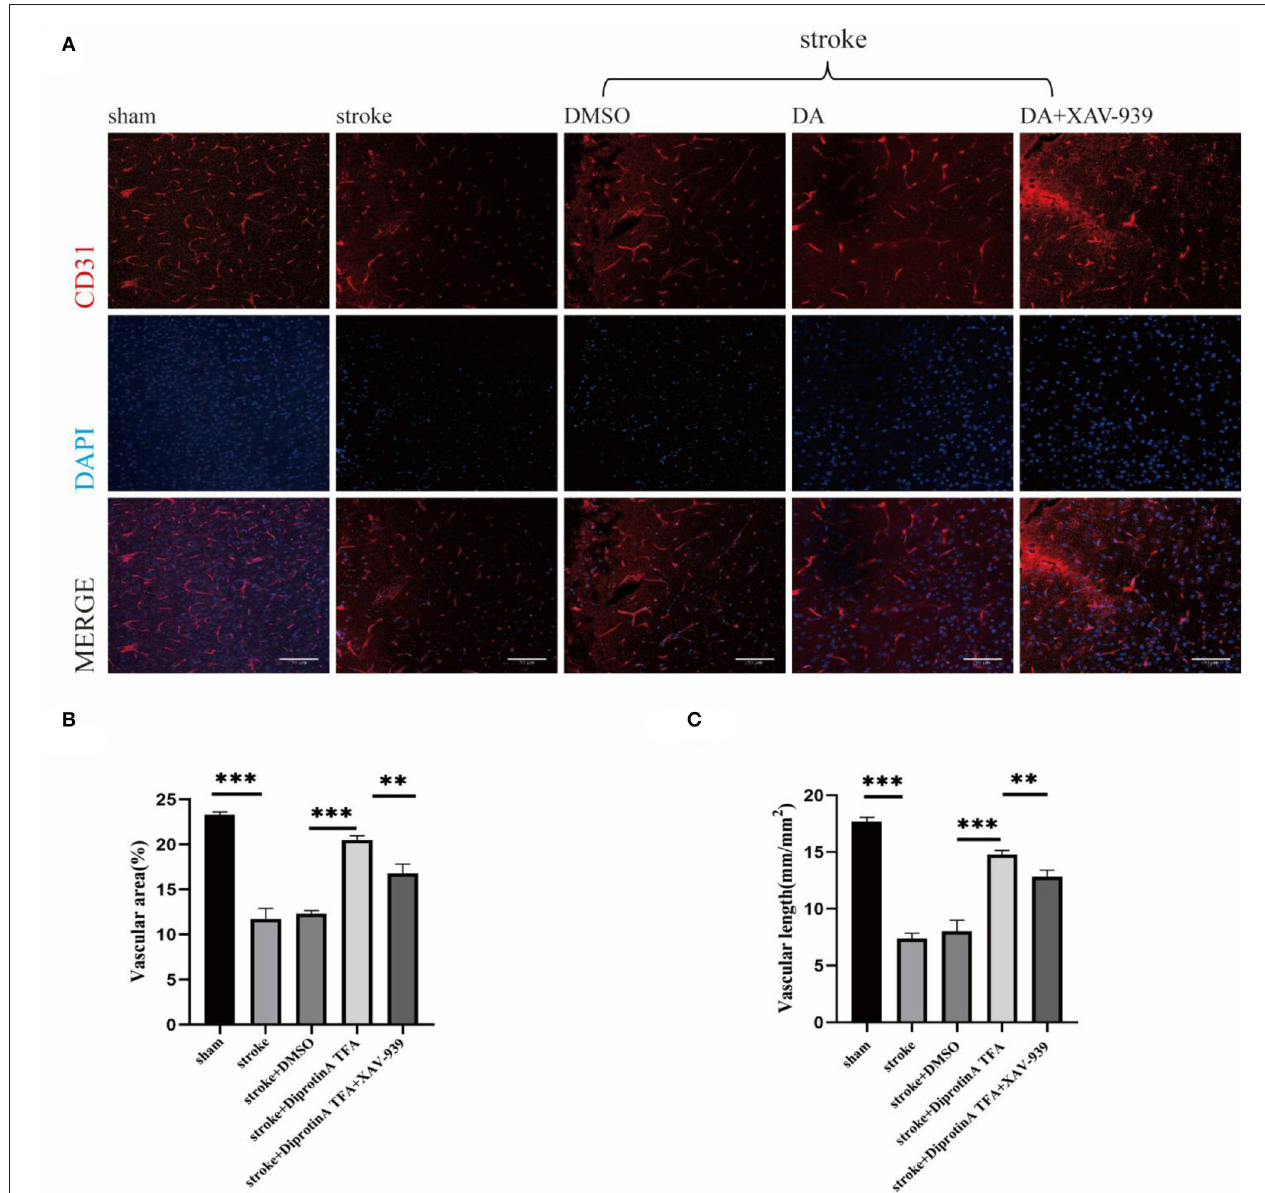
FIGURE 4 | Diprotin A TFA reduces the degree of vascular injury around cerebral infarction. (A) There are immunofluorescent staining images of CD31 (red) (antiplatelet endothelial cell adhesion molecule-1), which labels blood vessels. The slice thickness is 40 µ m. Bar = 50 µ m. (B) The statistical plot of vascular area. (C) The statistical plot of vascular length. The DA group had a statistically significant increase in the area and length of stained vessels relative to the vehicle control group. n = 3 per group. Data are represented as mean with SEM. ** p < 0.01, *** p <